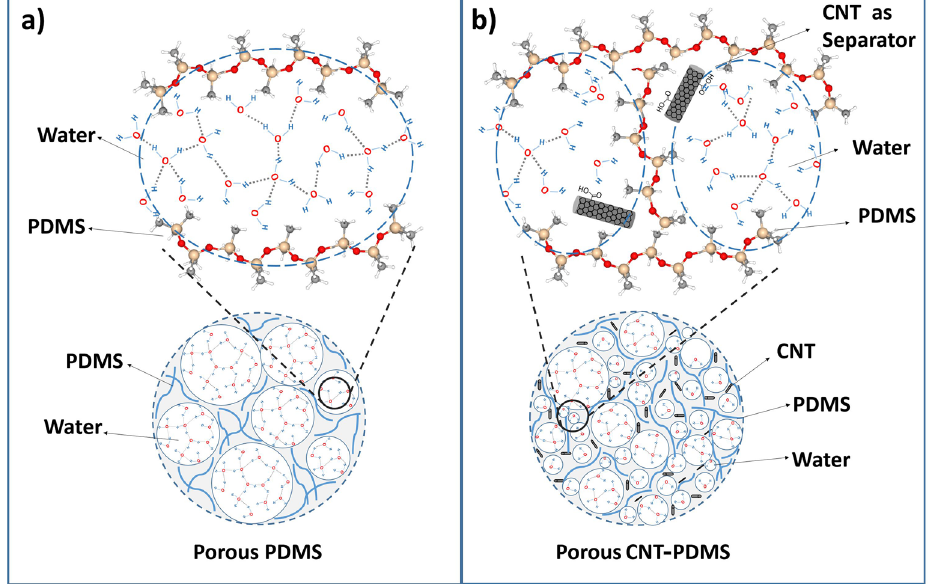
Figure 2. The formation of pores containing water molecules inside the PDMS network ( a ) and the CNT- PDMS network ( b ), where the presence of carbon nanotubes as a separating agent of water molecules causes the creation of smaller